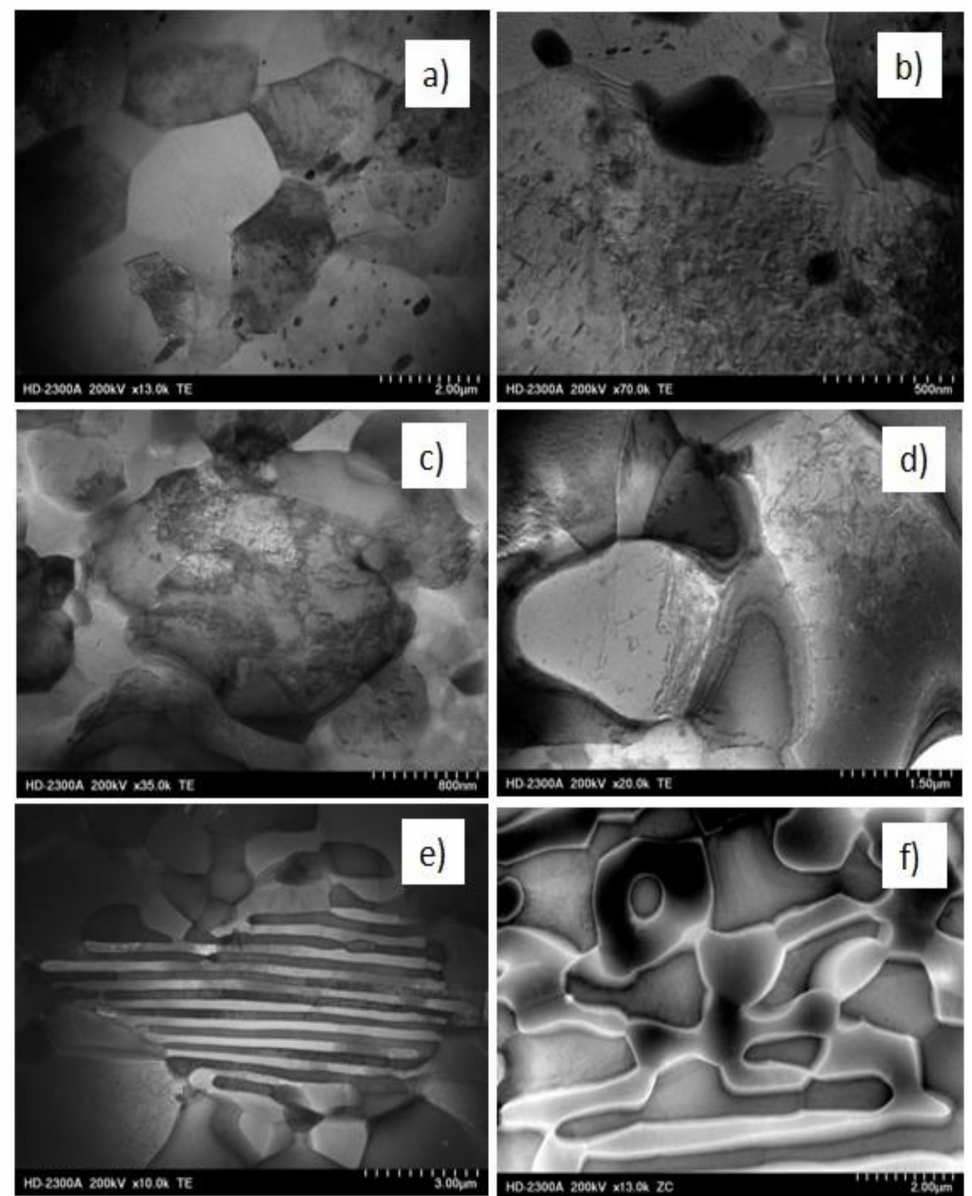
Figure 10. Scanning transmission electron microscope (STEM) images showing the characteristic microstructures of Al–Cu alloys after tensile test at 400 ◦ C. The microstructures on the left side represent ZC images, while the microstructures visible on the right side represent TE images. ( a , b ) Al 5 Cu alloy, ( c , d ) Al 25 Cu alloy, ( e , f ) Al 33 Cu